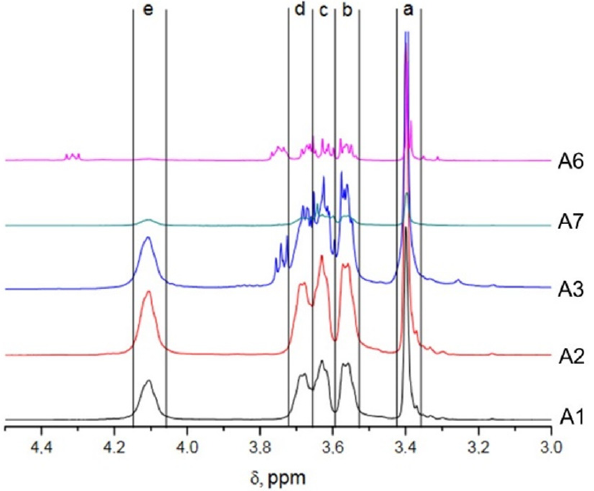
Figure 7. Comparison of NMR spectra of PS-b- PDMEEMA samples of different Mn.